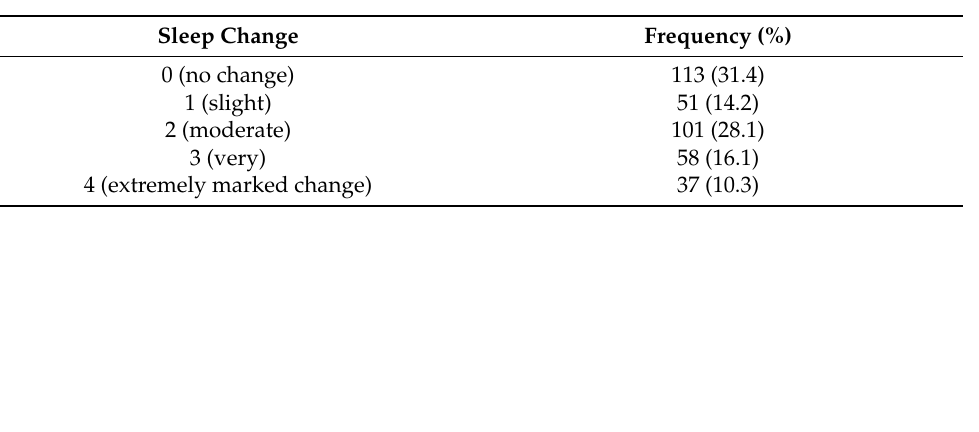
Table 4. How much sleep changes with seasons ( n =